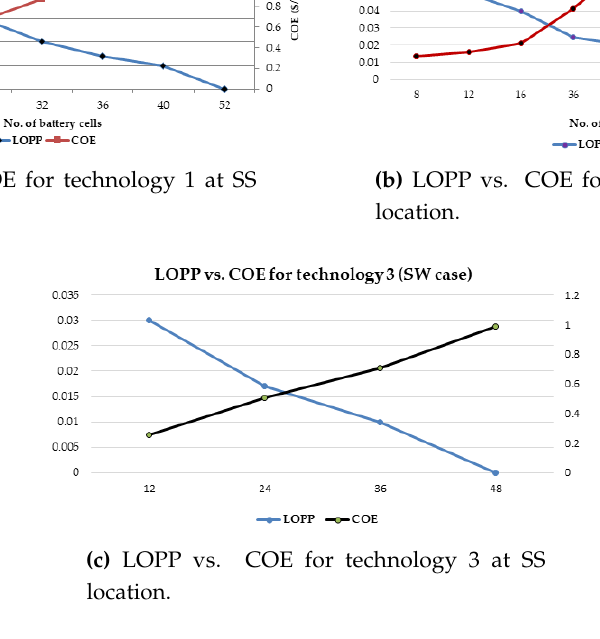
Figure 16. Technology selection for SS